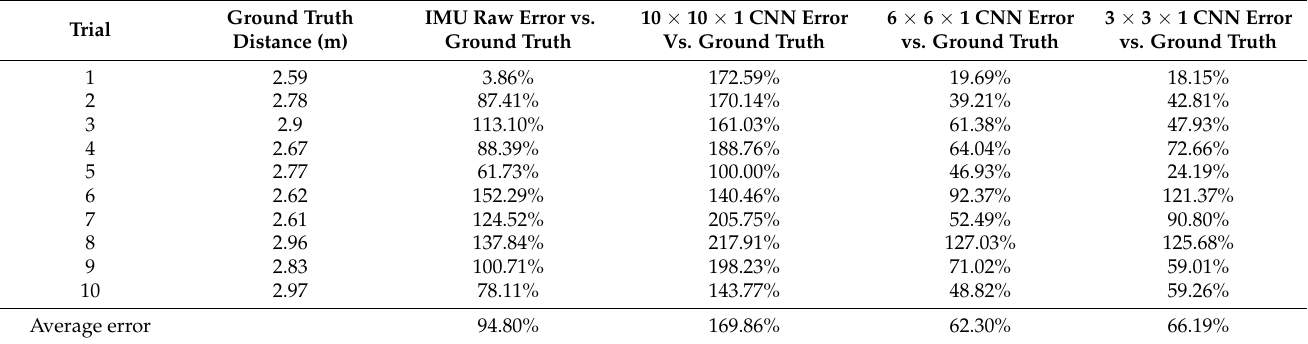
Table 7. Distance and percentage error results for TDK